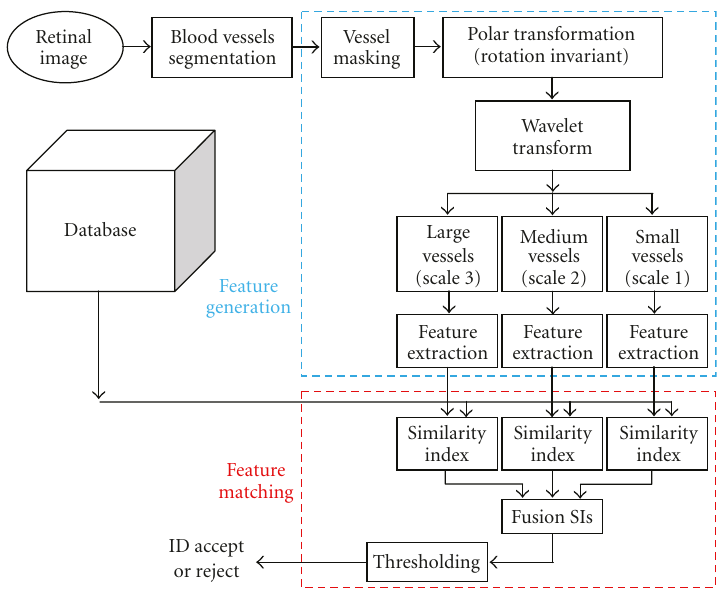
Figure 4: Overview of the proposed retinal identification